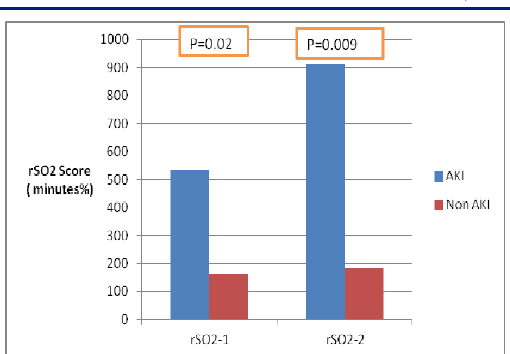
Figure 3: rSO2 score at different stages of surgery in AKI and non AKI group